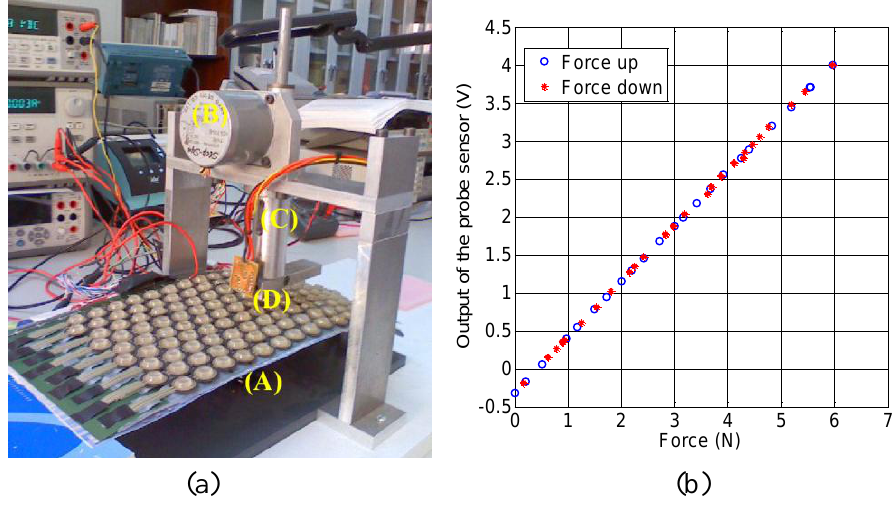
Figure 2. ( a ) Characterization set-up. ( b ) Calibration curve.